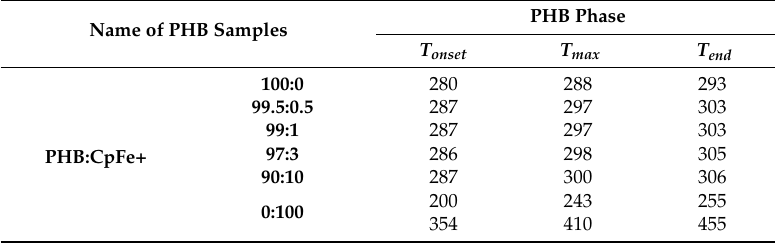
Figure 12. Thermogravimetry and differential thermogravimetry curves of the pure PHB and PHB/CpFe + nanocomposites. Table 5. Thermal stability parameters of PHB and PHB/ CpFe + nanocomposites.